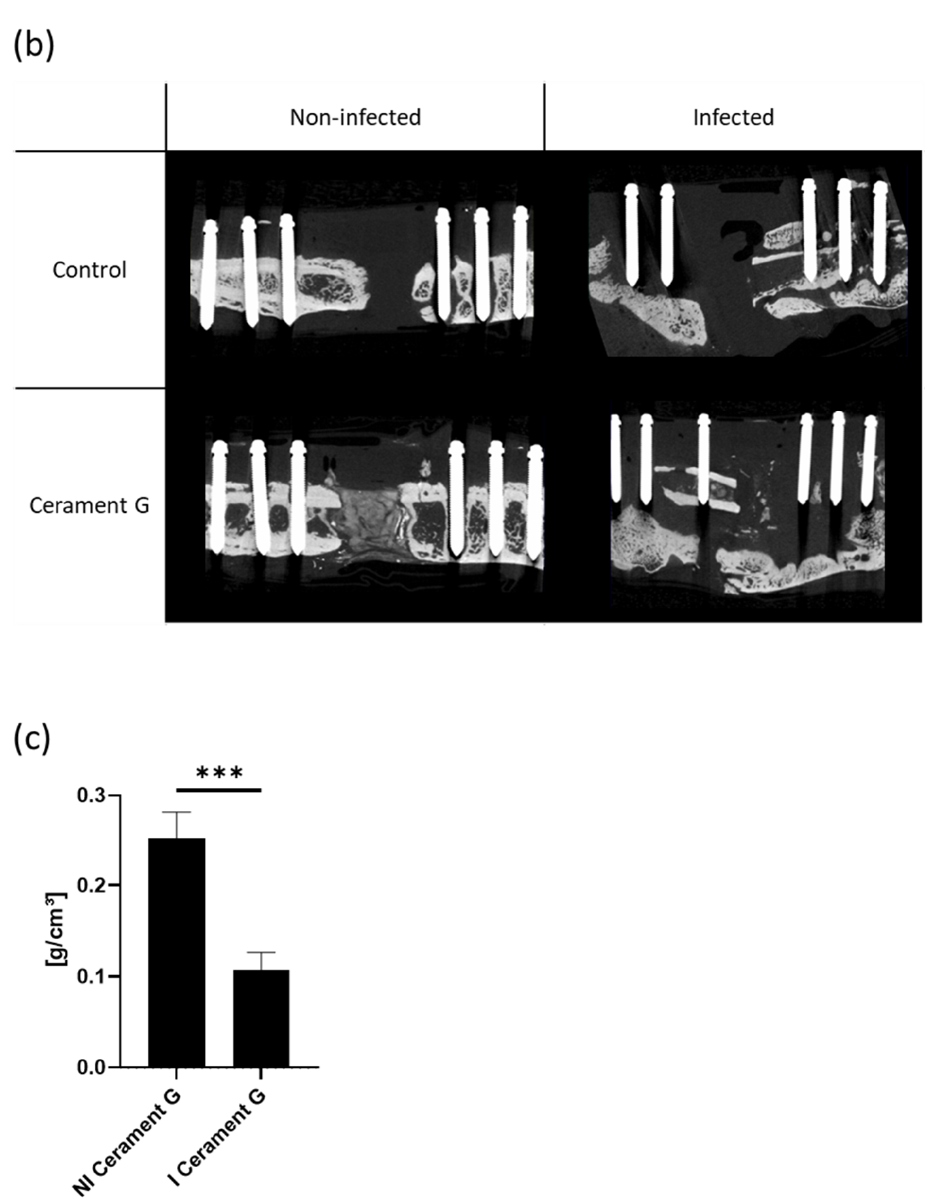
Figure 4. ( a ) µ -cT analysis of the bone graft four and eight weeks after the second surgery. Relative change describes the difference from the fourth to the eighth week. The relative change is measured within and between the groups. *** = p < 0.001, ** = p < 0.01, * = p < 0.05, ++ = p < 0.01 comparison of 4 to 8 weeks, + = p < 0.05 comparison of 4 to 8 weeks, ns = not significant. ( b ) The µ -CT images postmortem visualize the degradation of the bone graft substitute and the transformation of the surrounding bone in the infected groups. ( c ) Density of the bone graft Cerament G (BMD). The I Cerament G group shows significant less density than the NI Cerament group. *** = p <